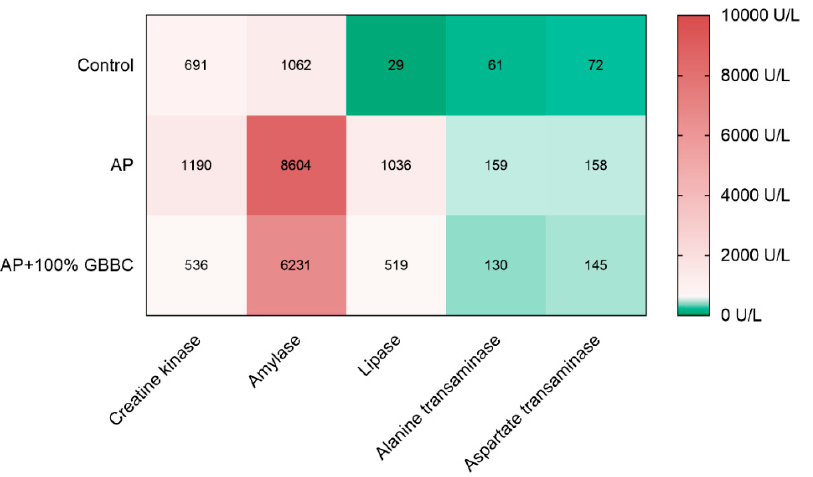
Figure 3. Heat map showing the relationship between various metabolic enzyme activities measured in healthy mice, mice with evoked acute pancreatitis (AP), and AP mice after administration of 100% GBBC. Hues of colors (from dark green (bottom scale) to faded red (top scale)) are represented by mean values.